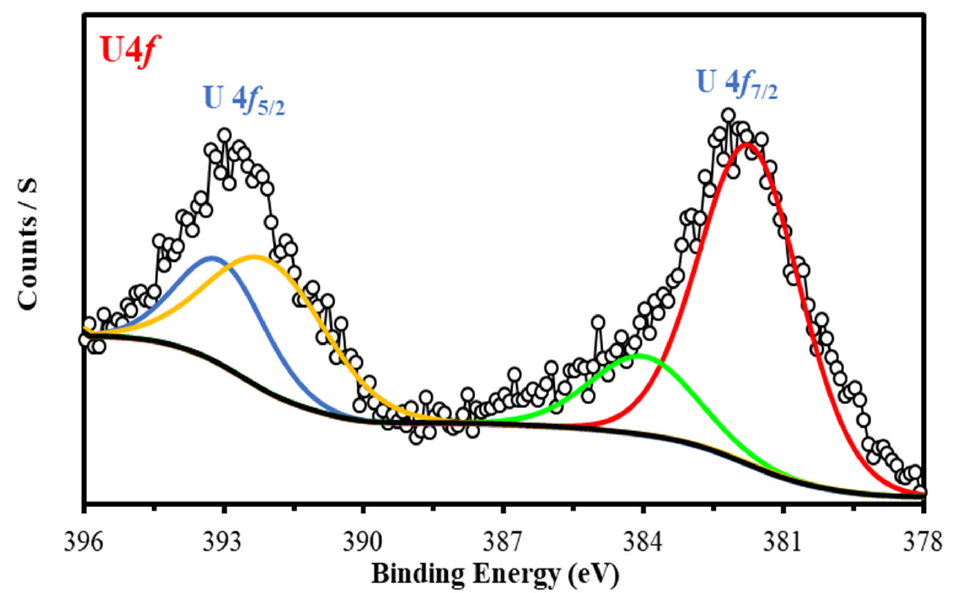
Figure 4. XPS survey spectra of raw Cys sorbent, after U (VI) sorption ( upper panel ) and core level for U 4 f7 ( lower panel ).